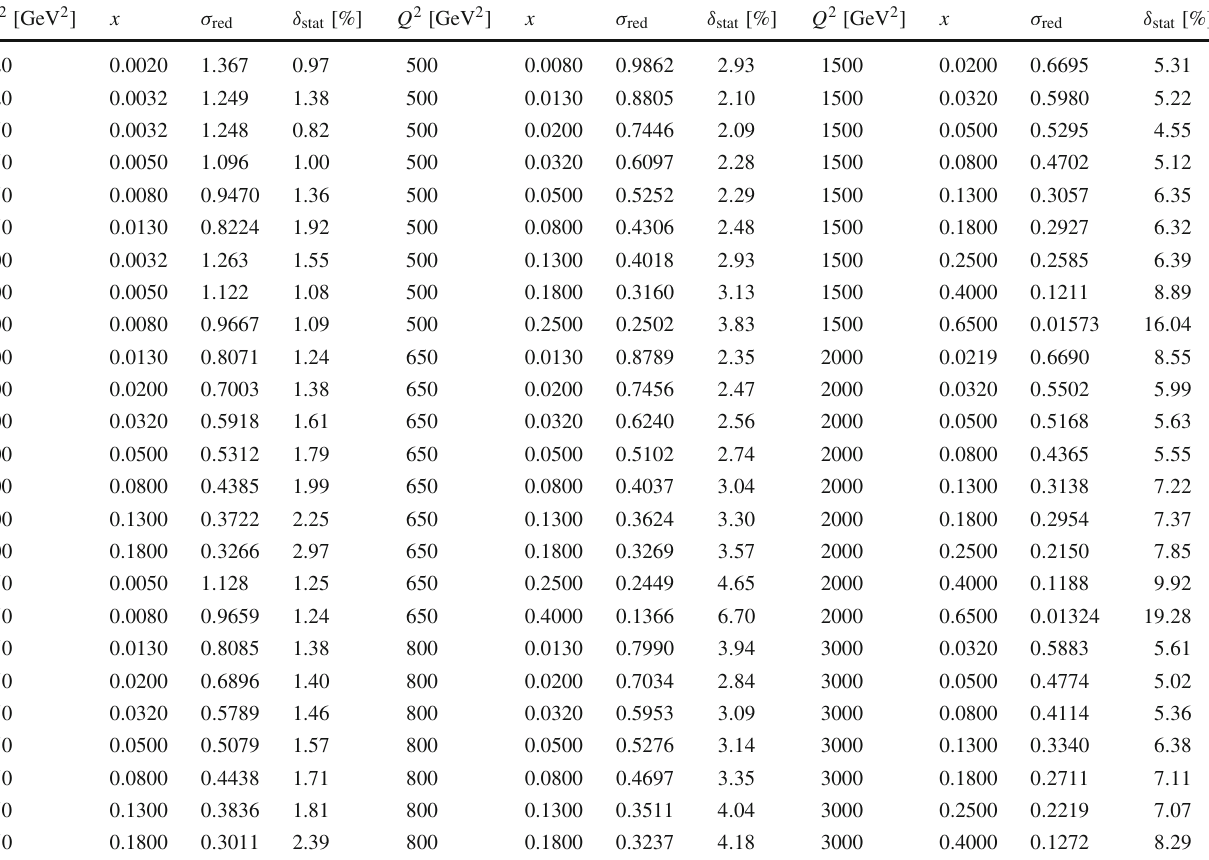
Table 8 The NC e + p reduced cross section σ red with lepton beam polarisation P e = − 37 . 0% with their statistical ( δ stat ) uncertainties. The full uncertainties are available in Ref. [58], while the respective cross section values are updated according to Sect. 3 and Ref.